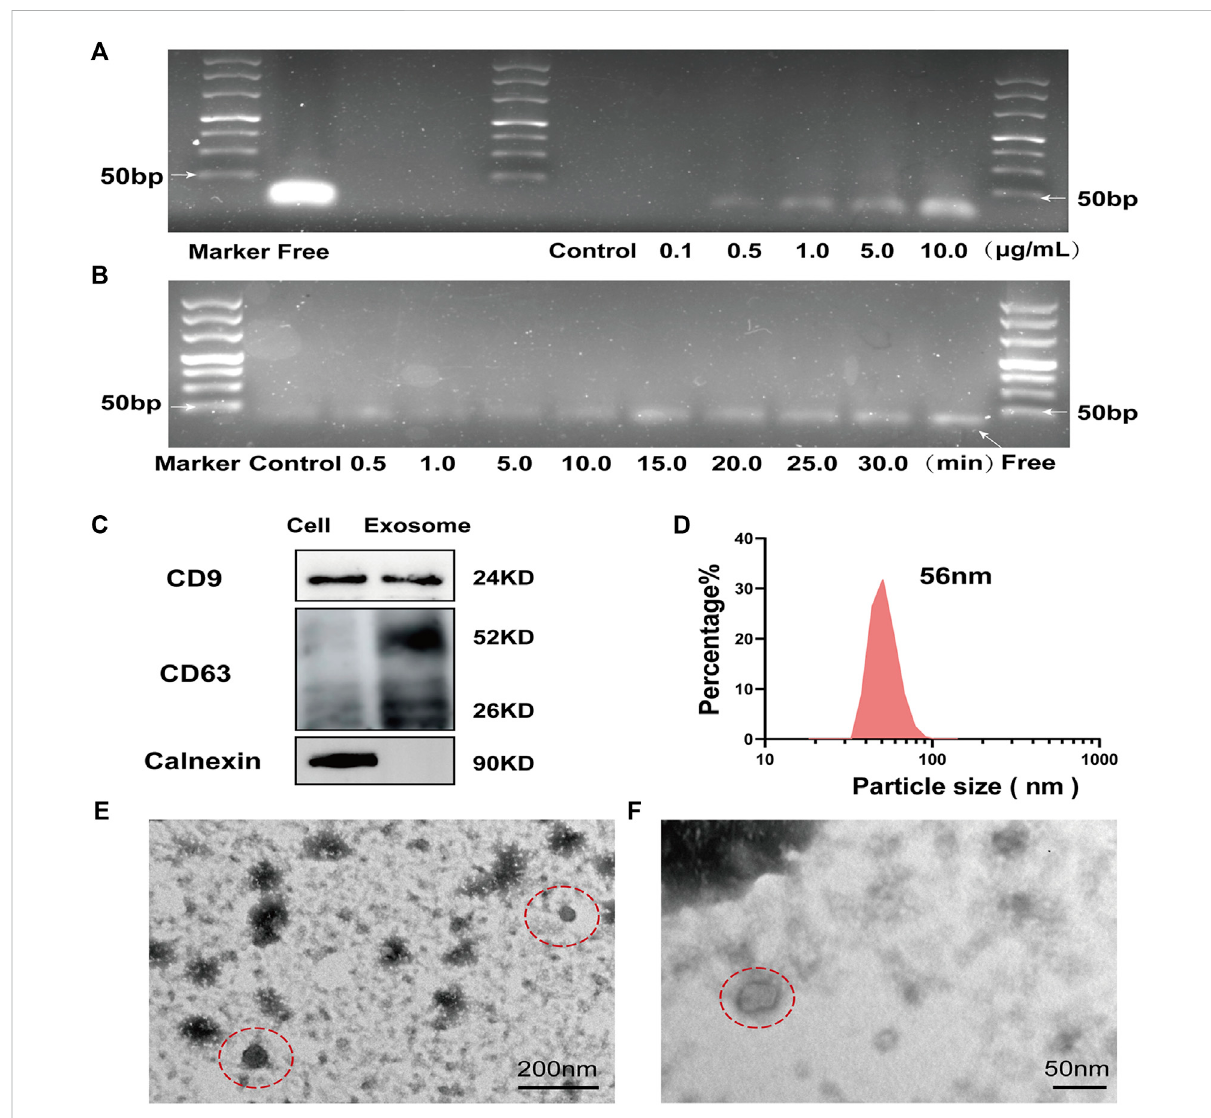
FIGURE 3 ResponseofMBs-Apt 63 toUV invitro andidenti fi cationofexosomes (A) Agarosegelelectrophoresis(molecularweightoffreeaptamer=32 bp) of MBs-Apt 63 at different concentrations after UV exposure; (B) Agarose gel electrophoresis of MBs-Apt 63 (10.0 μ g/ml) after exposure to UV for different times (molecular weight of free aptamer = 32 bp). (C) The expression of CD9, CD63 and calnexin determined by western blotting; (D) The particle size of breast cancer cell exosomes characterized by DLS; (E , F) Transmission electron microscopy image of breast cancer exosomes (magni fi cation = 50000× in C and 100000× in D , exosomes are shown in the red dotted